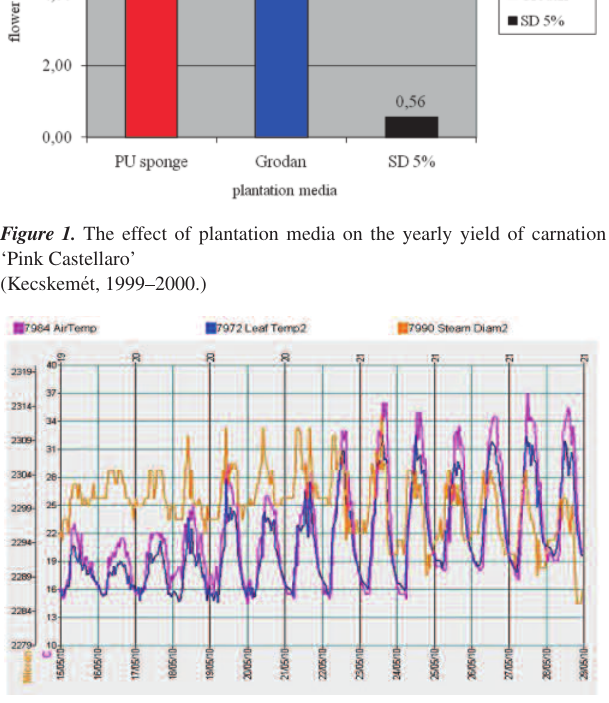
Figure 2. The effect of air temperature on rose leaf temperature and expansion of stem (2010.Kecskemét,)